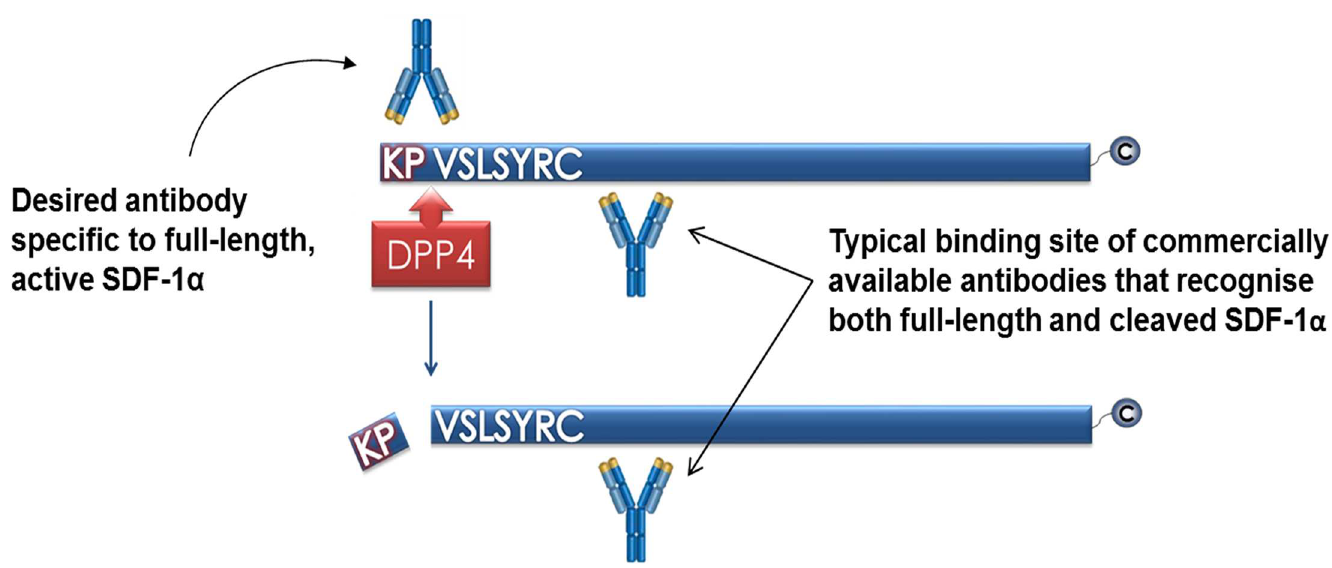
Fig 1. Representation of binding sites of HCI.SDF1 α and commercialantibodies on full-length SDF-1 α and SDF-1 α after cleavageof its N- terminal di-peptide by DPP4.